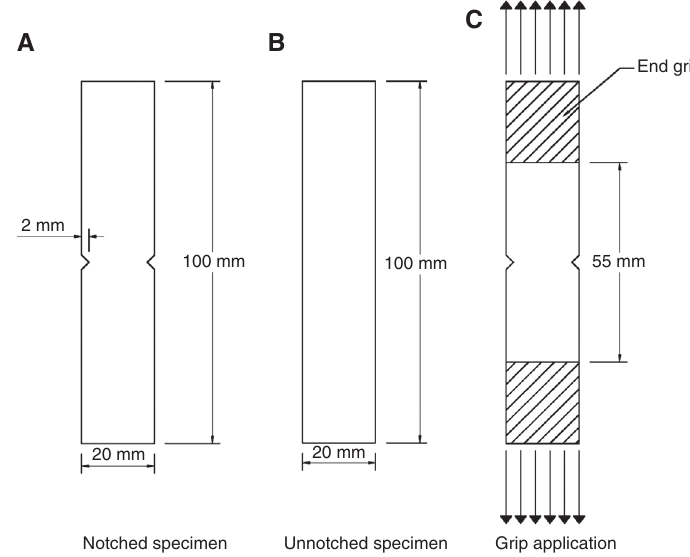
Figure 4 Tension test specimens.